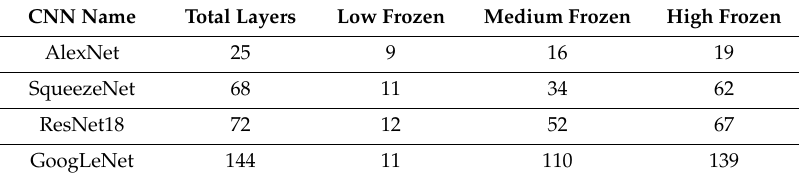
Table 3. Number of frozen layers at di ff erent levels and for the CNN analyzed.